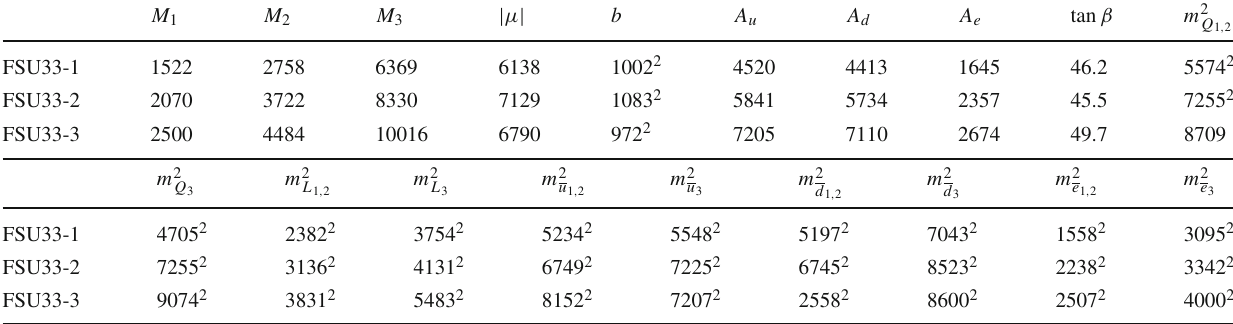
Table 7 Finite N = 1 SU ( 3 ) 3 predictions that are used as input to SPheno . Mass parameters are in GeV and rounded to 1 GeV